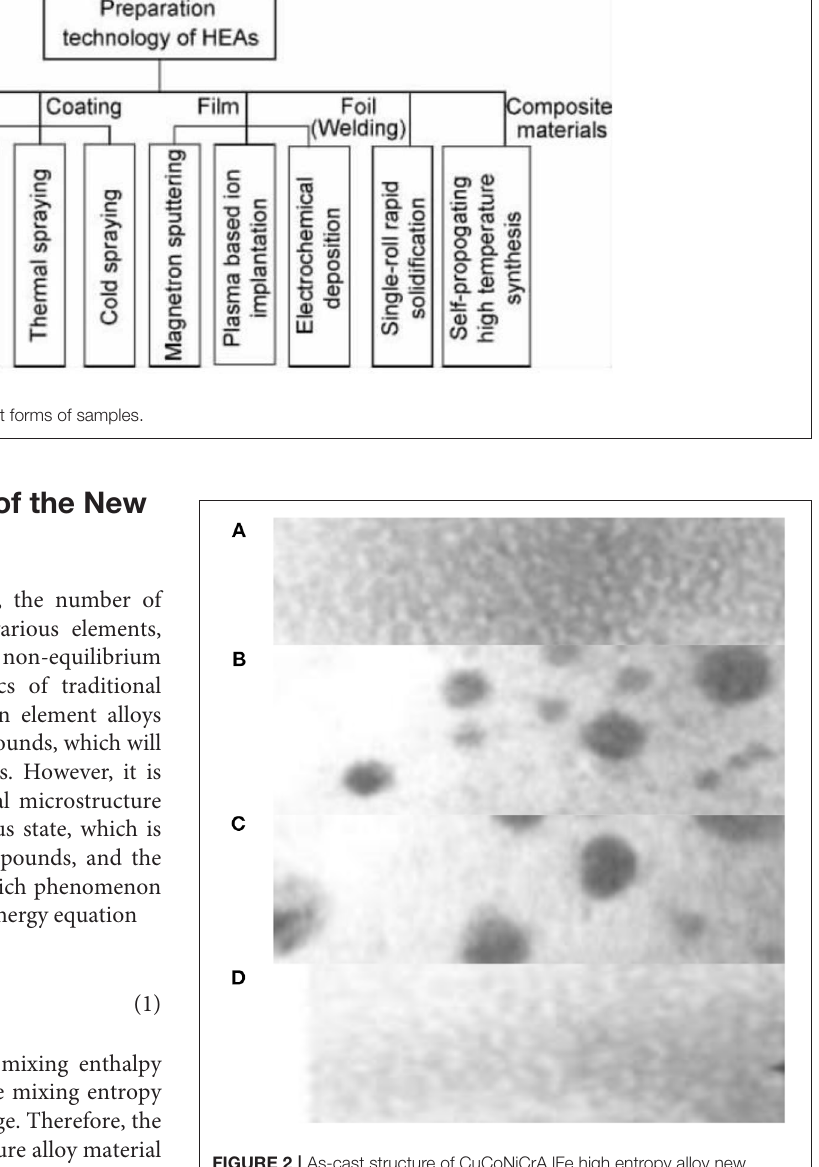
FIGURE 2 | As-cast structure of CuCoNiCrA lFe high entropy alloy new material. (A) Near disordered BCC phase structure with a width of 70 nm. (B) Ordered BCC phase structure with a width of 100 nm. (C) The structure of nano precipitate and FCC with size of 7–50nm. (D) Near disorder BCC phase